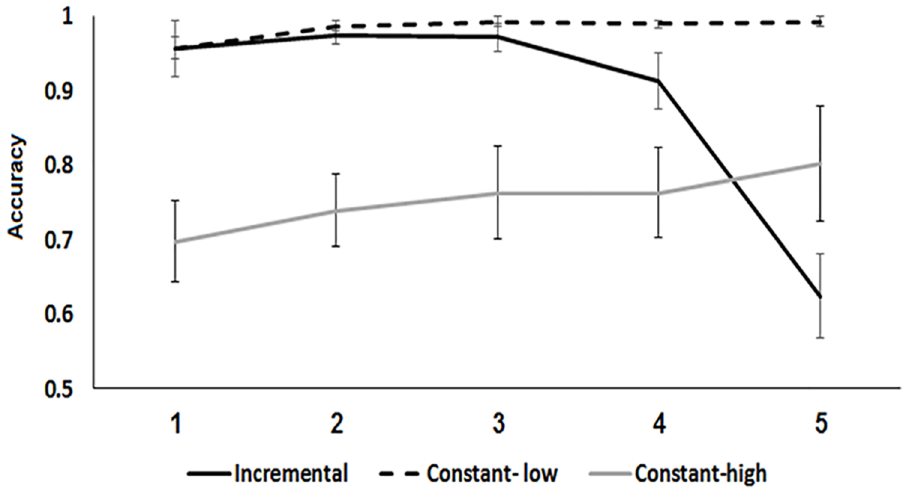
Fig 4. Training-phase performance of the constant-low compression, constant-high compression and adaptive-incremental groups as a function of training block. Note that whilein the two constant conditions all 5 blocks were maintainedat a singleset level of task difficulty (level of compression 60% and 30%, in the constant-low compression and constant-high compression, respectively)in the adaptive- incremental conditiontask difficulty was increasedacross blocks (60%, 50%, 40%, 30%, 20%, blocks 1–5 respectively). Error bars show the 95% confidenceinterval of the mean.